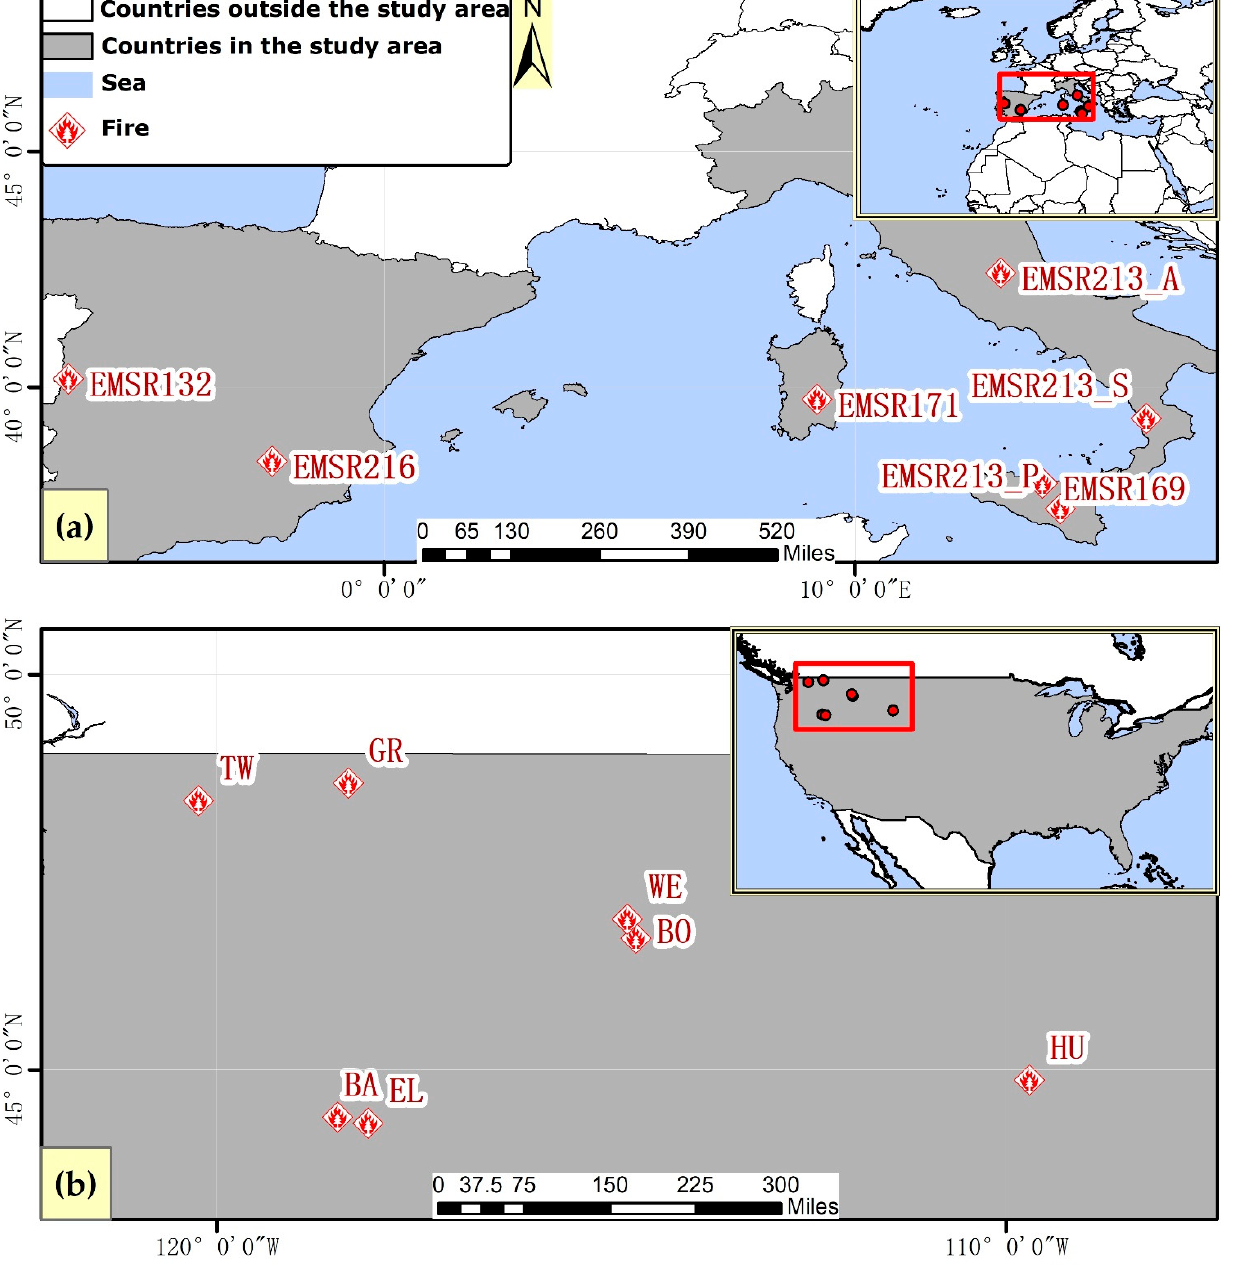
Figure 1. Study area and the location of the fires in ( a ) the European Mediterranean region; ( b ) the northwestern continental United States region.